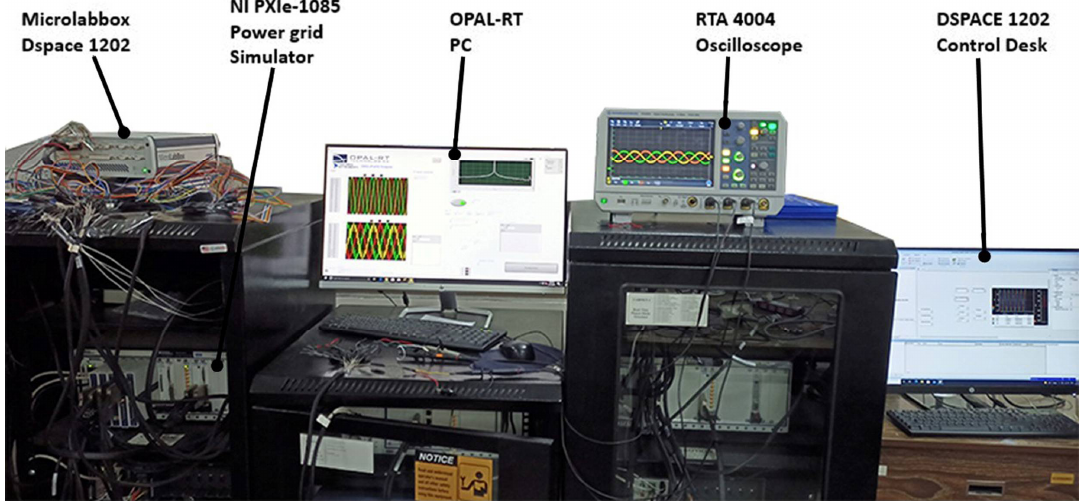
Figure 11. HIL setup containing DSPACE-1202 and PXIe-1085 power grid simulator.